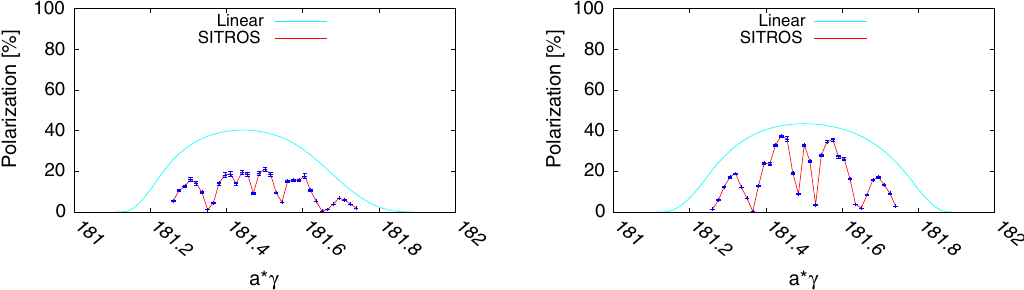
FIG. 11. 60 ° = 60 ° FODO. Polarization vs. spin tune after orbit is corrected with SVD in presence of BPMs errors. δ ˆ n 0 is corrected by 8 3-correctors harmonic bumps (left) or by 8 dispersion-free 5-correctors harmonic bumps